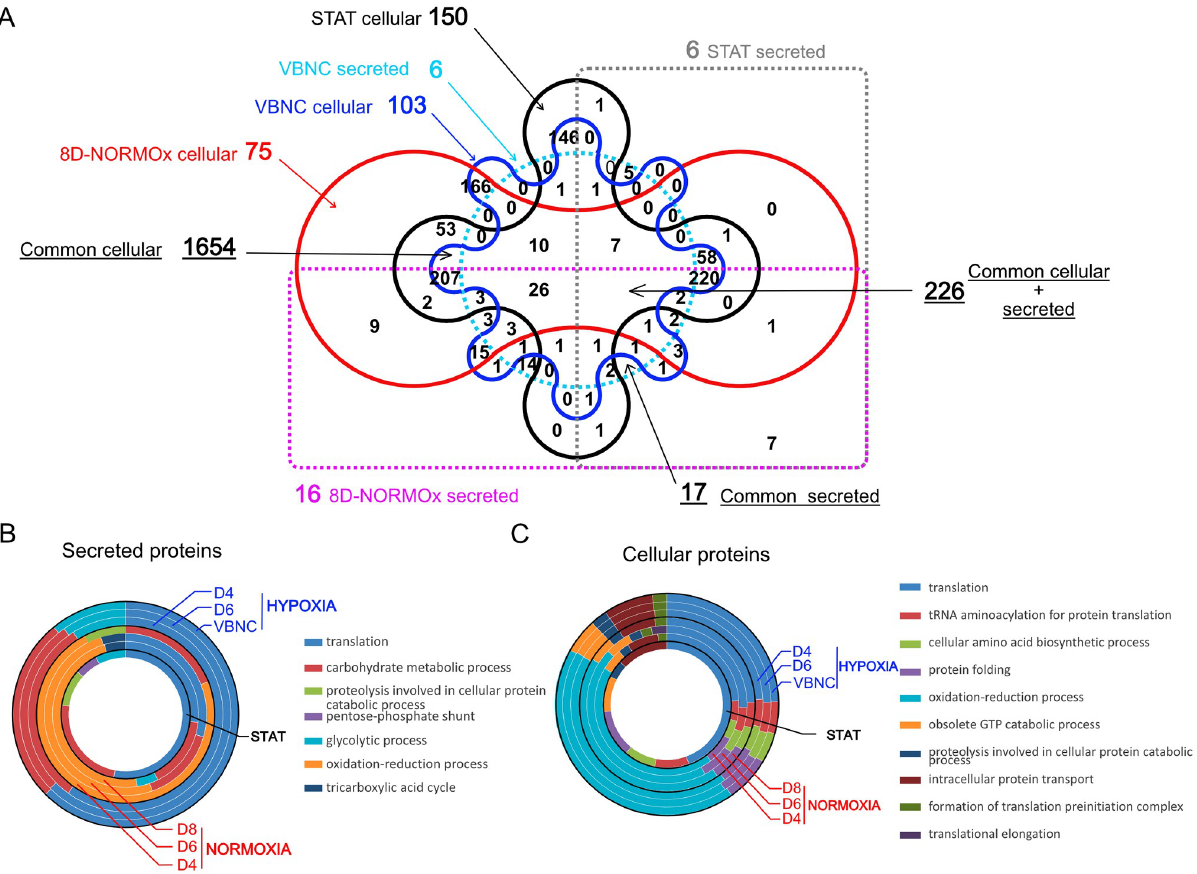
Fig 6. Secretome and proteome qualitative analysis showed specific features in VBNC. A . Venn diagram of cellular and secreted proteins in stationary phase (STAT), VBNC and 8D-NORMOx. Six secreted (clear dashed blue) and 103 cellular (deep blue) proteins were detected specifically in VBNC. Six were secreted only in STAT (grey dashed line) and 150 were detected in cellular protein only (dark line), 16 were secreted (pink dashed line) and 75 cellular (red line) only in 8D-NORMOx. Only proteins present in the 3 replicates for each condition were selected and compared. B . GO enrichment analysis of secreted proteins showed specific profile in VBNC. The major biological processes enriched in VBNC were translation, metabolic process of carbohydrates and glycolytic biological processes whereas oxidation-reduction was mainly enriched in 8D-NORMOx. C . GO enrichment analysis of cellular proteins showed similar profiles in VBNC and 8D-NORMOx with an enrichment for translation and oxidation- reduction.